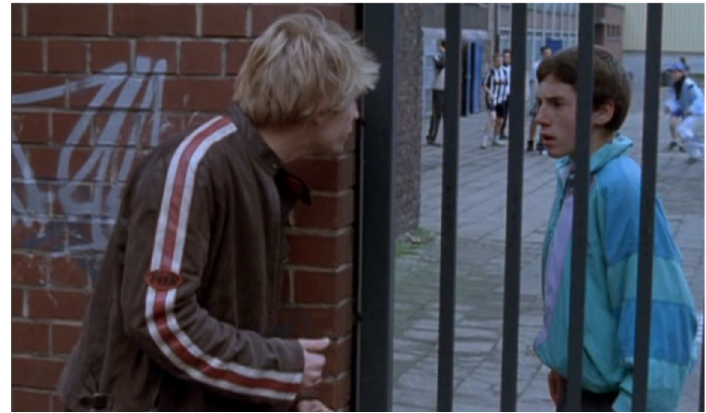
Figure 8. Isolation.